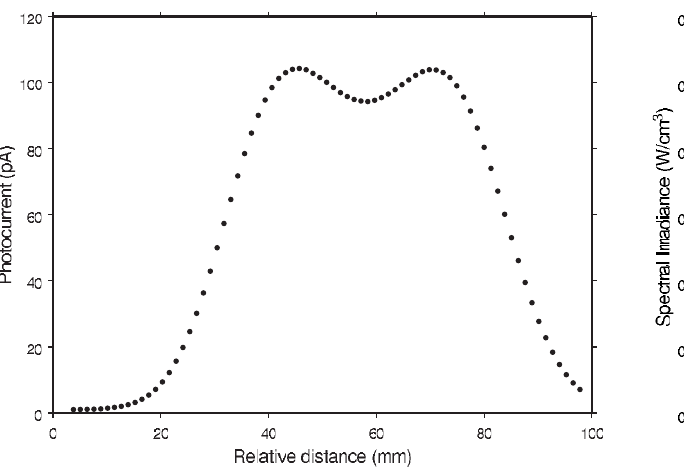
FIG. 8. (Color) Absolute irradiance measurement of the angular distribution of synchrotron radiation at 256.5 nm using FR1. All results are normalized to 1 mA of SURF III current with the top curve measured at a SURF energy of 380 MeV followed by 285, 180, and 105 MeV. The lines are the results of calculations using Schwinger’s equation.